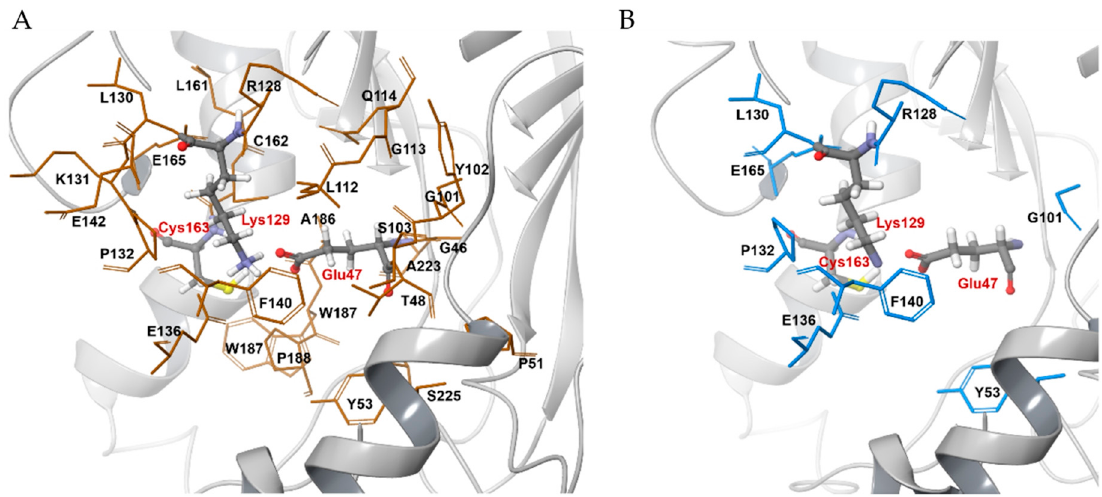
Figure 4. Residues within the 4.5 Å radius centered on the catalytic residues of NitAF. ( A ) In total, 28 residues, including the three conserved catalytic residues (Cys-163, Glu-47, and Lys-129), were found to be within 4.5 Å from the catalytic site of NitAF. ( B ) Conserved residues within the 4.5 Å sphere across the whole nitrilase family. Only 8 out of 25 residues were conserved across the whole nitrilase